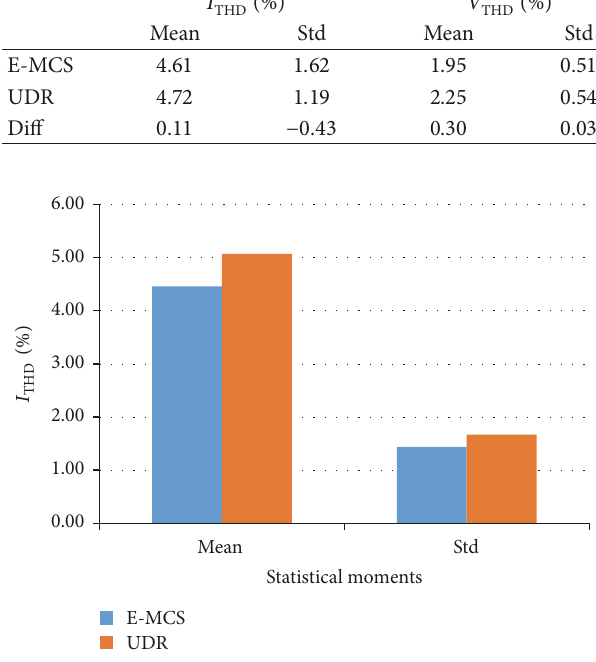
Figure 11: Predicted IgaTHD using E-MCS and rUDR 5 pts for Uniform Power Variation.